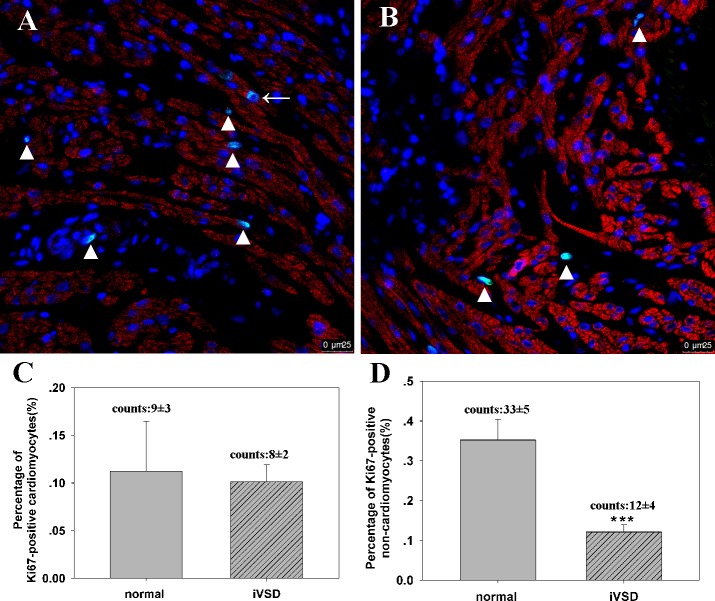
Proliferation of iVSD cardiomyocytes analyzed via confocal microscopy.Confocal microscopy of tissue sections using Ki67 and troponin indicate that non-cardiomyocyte cell proliferation is decreased in iVSD tissues compared to controls. (A) Representative Ki67-positive cells in normal hearts. (B) Representative Ki67-positive cells in iVSD hearts. (C) Quantification of Ki67-positive cardiomyocytes. (D) Quantification of Ki67-positive non-cardiomyocytes (iVSD group: n = 20; control group: n = 6. Data presented as means ± SD; ***p<0.001. Cardiac troponin T (red), Ki67 (green), and DAPI (blue) staining are shown. Arrow indicates proliferating cardiomyocytes and the triangle indicates non-cardiomyocytes.